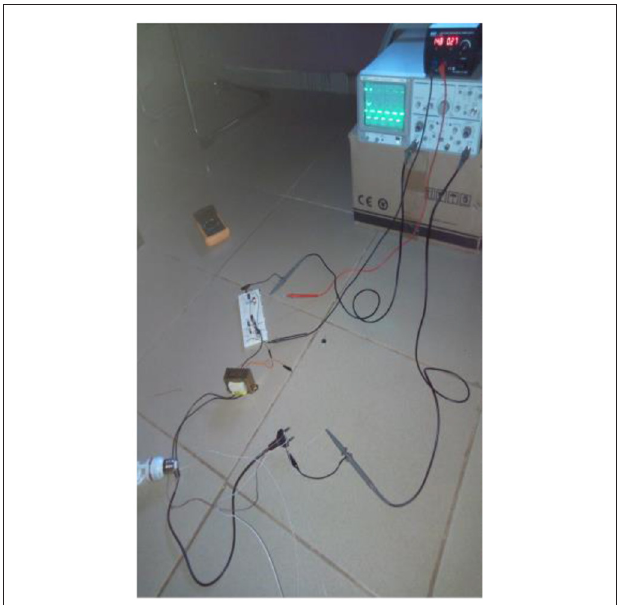
FIGURE 6 | FFT plots of converter output voltage: (A) 5-Hz converter; (B) 50-Hz converter.